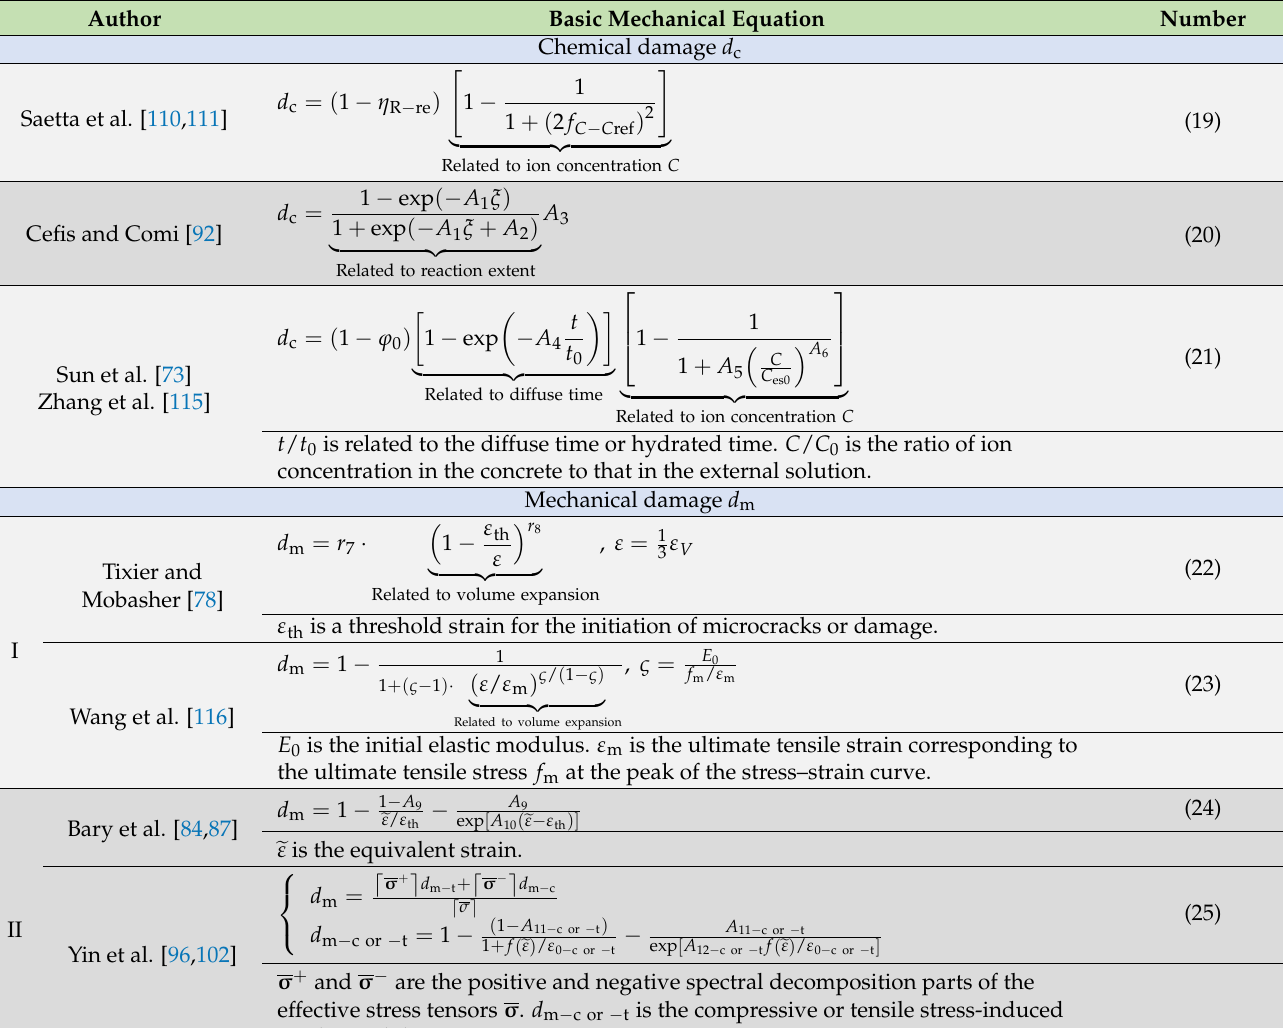
Table 7. Expressions of damage degree in concrete caused by